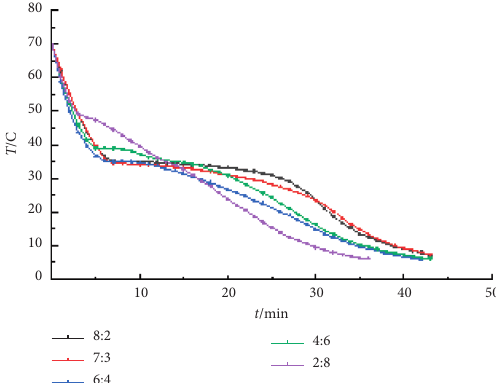
Figure 1: Step cooling curve of TD-MA binary composite phase change materials under different mass